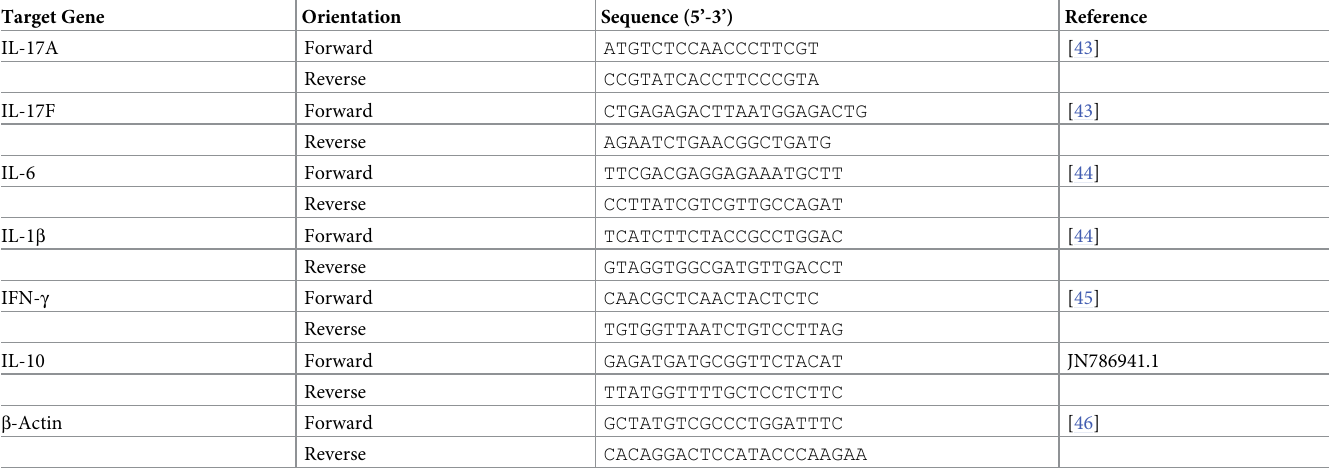
Table 1. Sequences of primers used for qRT-PCR analysis of cytokine expression. Target